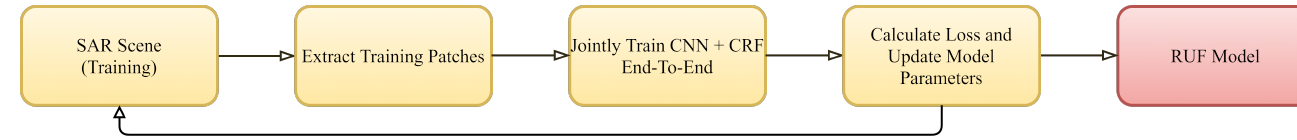
Figure 4. Model training pipeline. Input SAR image is processed as illustrated in Figure 2 to extract patches for the training batch. These patches are fed to the model and the model parameters are updated according to the loss.